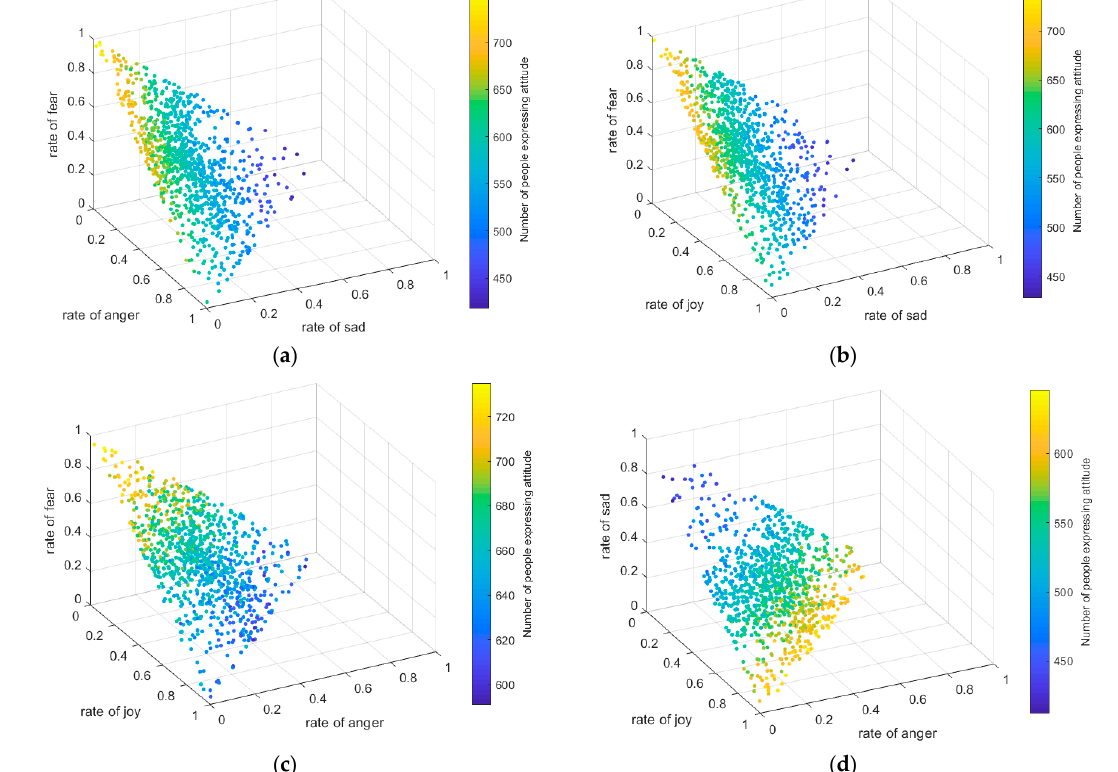
Figure 8. The number of individuals expressing attitude under different emotion proportion. ( a ) The number of individuals expressing attitude when rate of joy is 0, and other three emotions add to 1. ( b ) The number of individuals expressing attitude when rate of anger is 0, and other three emotions add to 1. ( c ) The number of individuals expressing attitude when rate of sadness is 0, and other three emotions add to 1. ( d ) The number of individuals expressing attitude when rate of fear is 0, and other three emotions add to 1.